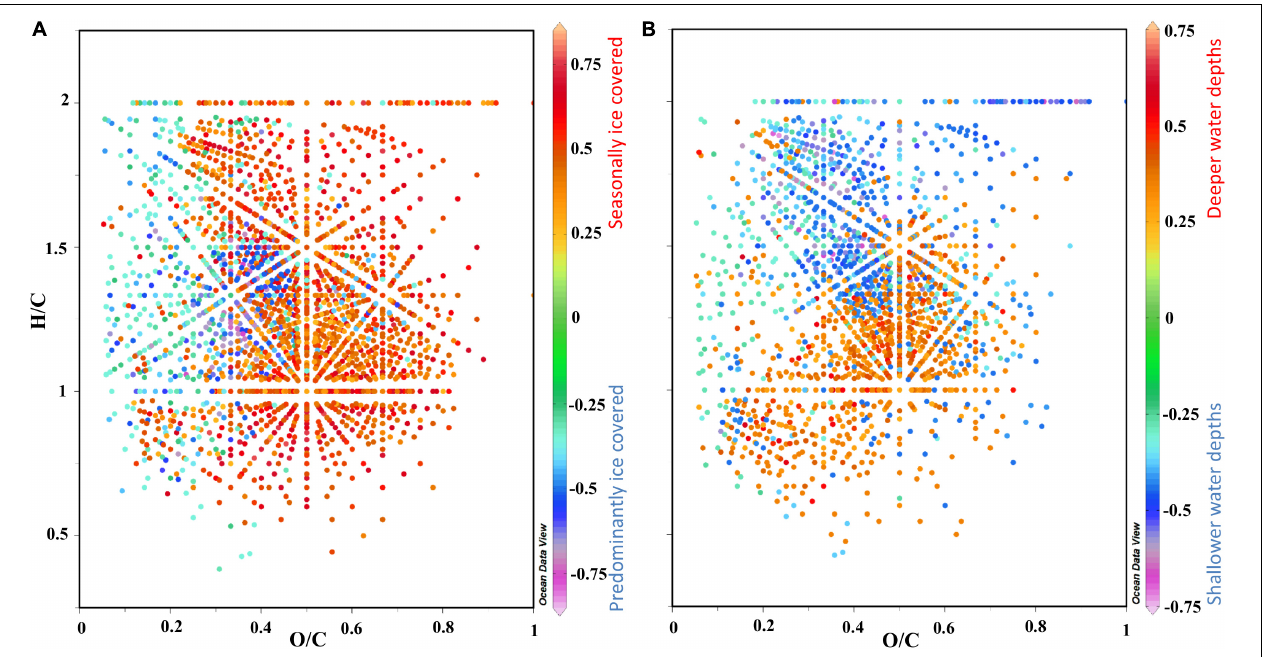
FIGURE 7 | van Krevelen diagrams (VKD) of H/C and O/C ratios using the PLS molecular loadings from Figure 6D to summarize the main trends in the molecular composition of surface porewater. (A) VKD with factor 1 loadings and (B) factor 2 loadings in the z axis indicated in the color bar to the right, where the relationship to sea ice cover and water depth are indicated (see Figure 6 ). For definition and location on the VKD of discussed molecular categories see section “Molecular Analysis of DOM via FT-ICR-MS,” Supplementary Figure S1 and Supplementary Table S2